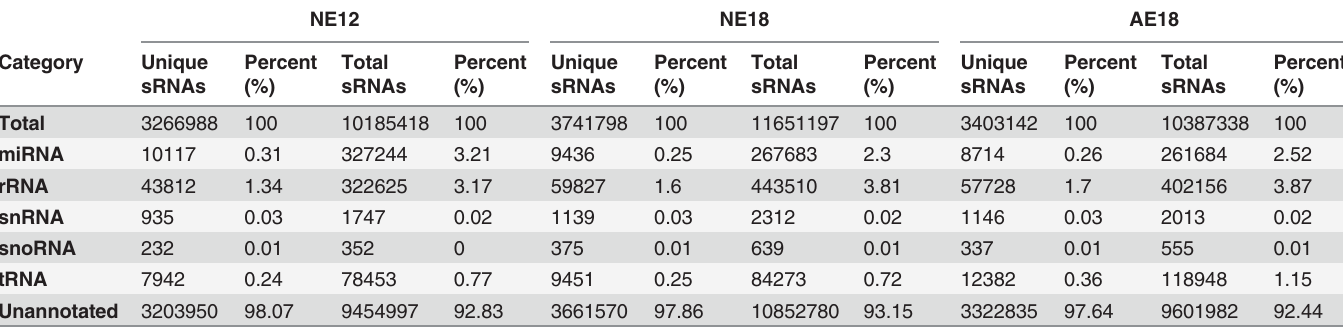
Table 2. Distribution of small RNAs among different categories in chrysanthemum. NE12 NE18